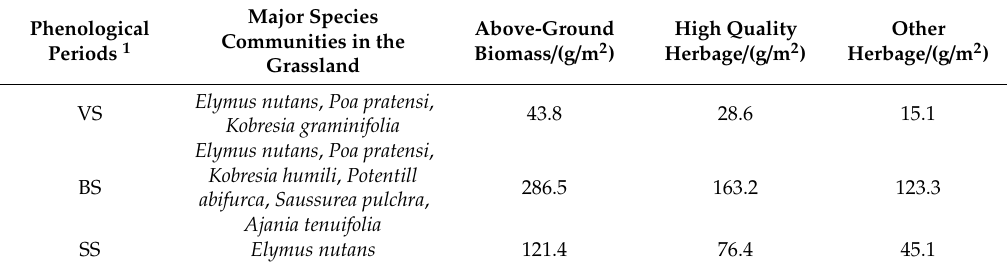
Table 1. Major species and proportion of herbage in di ff erent phenological